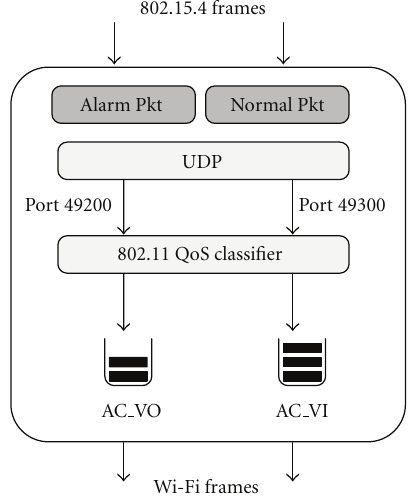
Figure 9: Queuing model from Gateway Router to Wi-Fi